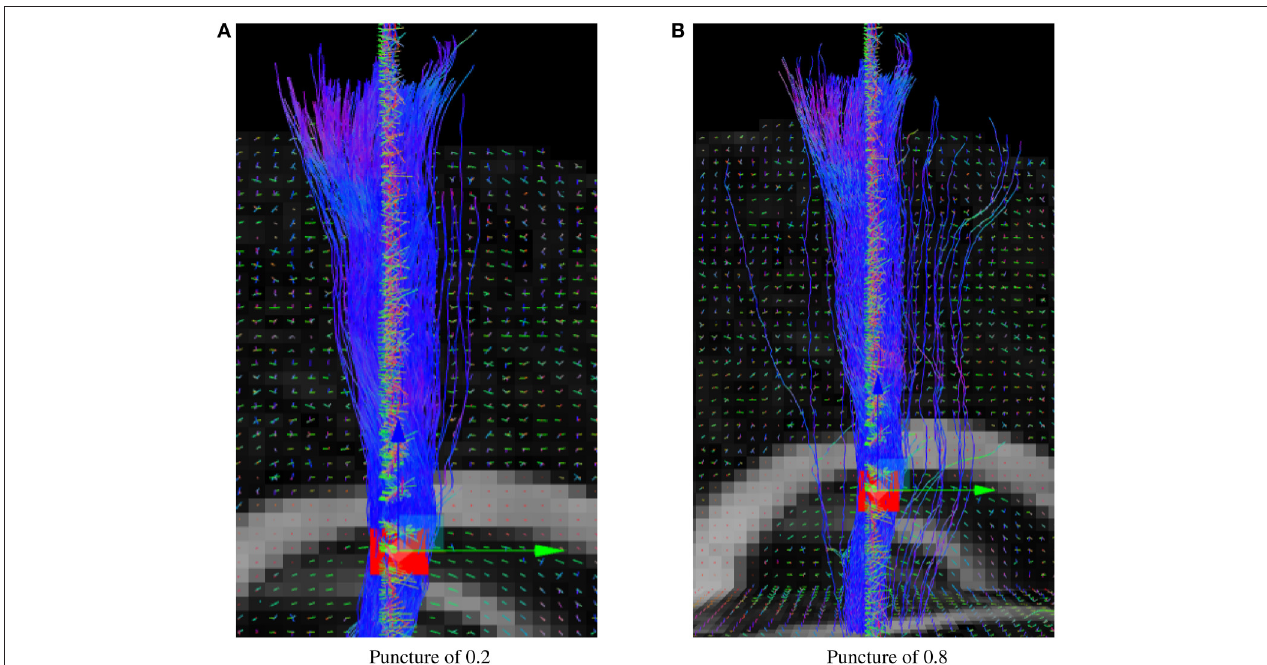
FIGURE 9 | Probabilistic RTT of the CST for different puncture values. (A) Results of the Fiberweb algorithm with a puncture value of 0.2. (B) Results of the Fiberweb algorithm with a puncture value of 0.8.